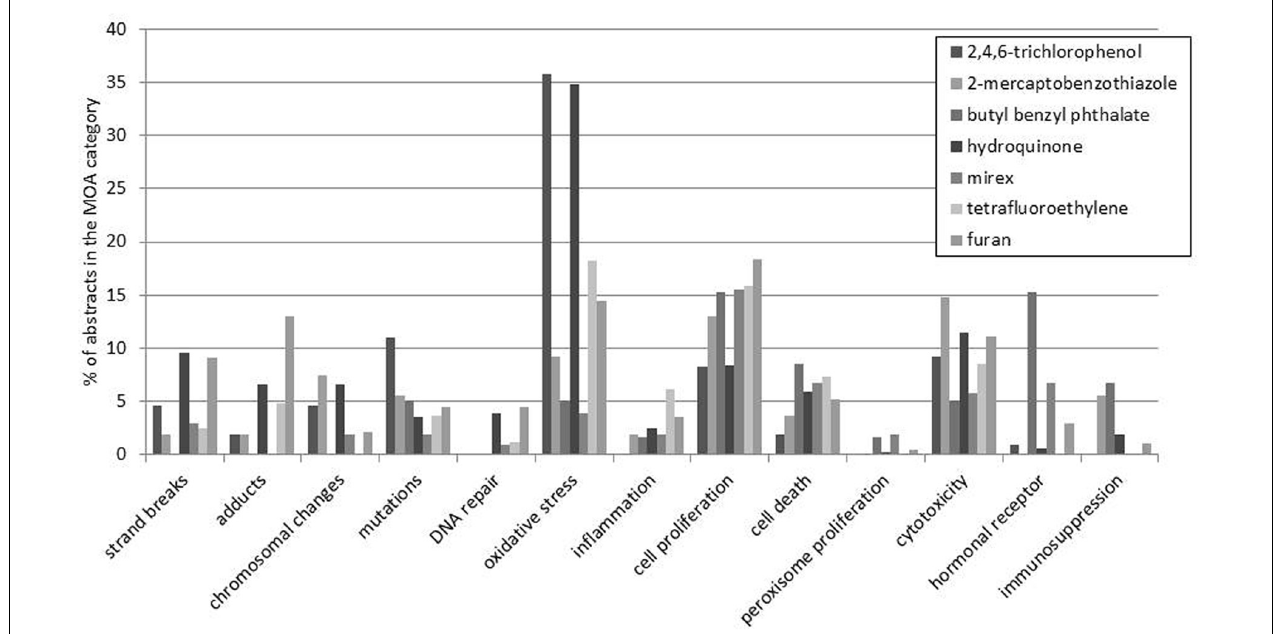
FIGURE 4 | Seven non-mutagenic rat carcinogens of the hematopoietic system were investigated in more detail. The figure shows 13 selected MOA categories and the literature distribution over these classes for carcinogens affecting the hematopoietic system in rats.